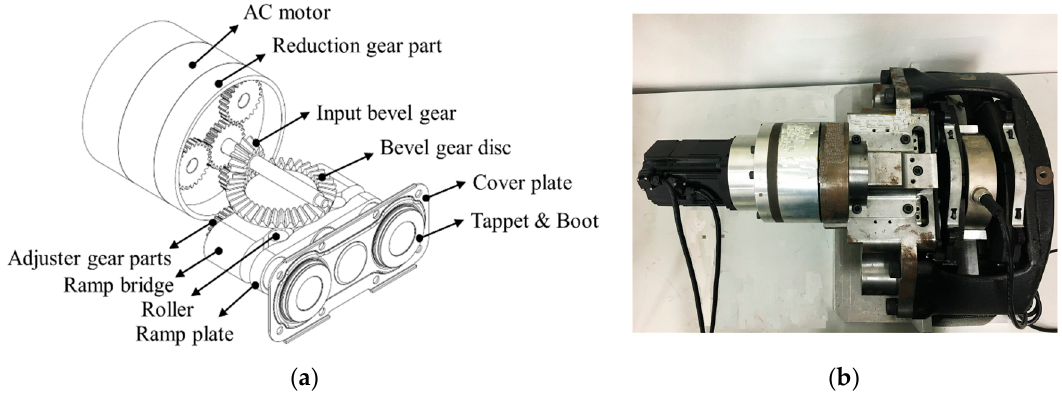
Figure 1. A proposed EMB system: ( a ) EMB schematics; ( b ) Real view of an EMB system.